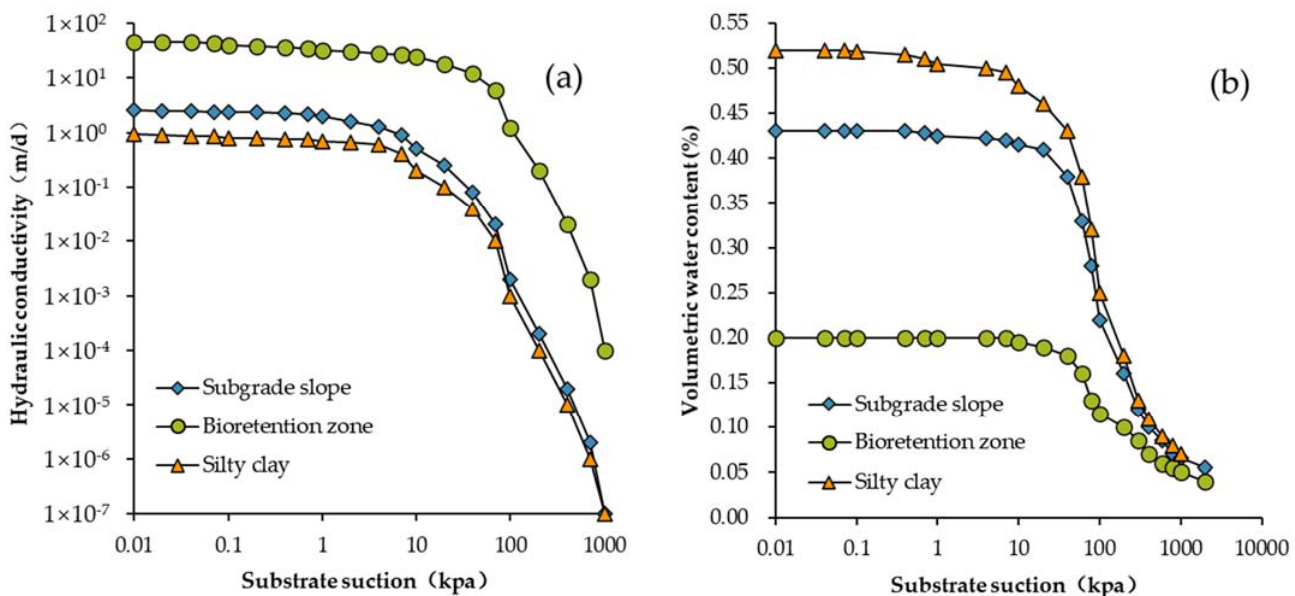
Figure 4. Hydraulic conductivity ( a ) and soil-water characteristic ( b ) curves of different materials.